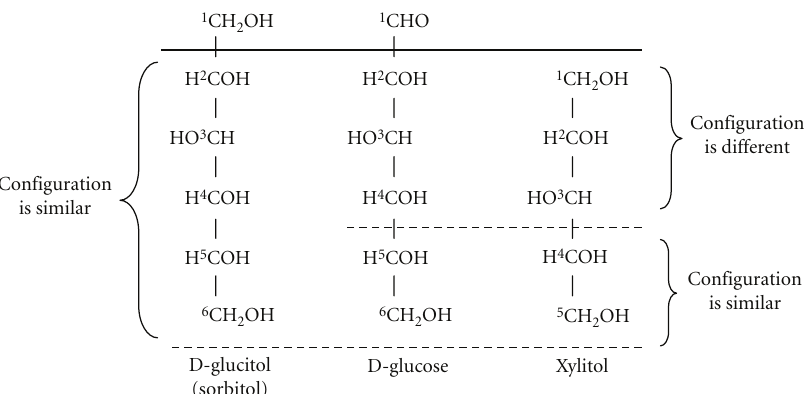
Figure 2: Relationship between the structural configurations of sorbitol ( D -glucitol), D -glucose, and xylitol. The molecular configurations of sorbitol and glucose are relatively similar. Hence, sorbitol can be called a “glucose-polyol”. The configuration of xylitol (a “non-glucose polyol”) markedly di ff ers from the two other configurations. The close similarity of sorbitol with glucose partly explains its plaque-promoting and mutans streptococci-stimulating e ff ects.